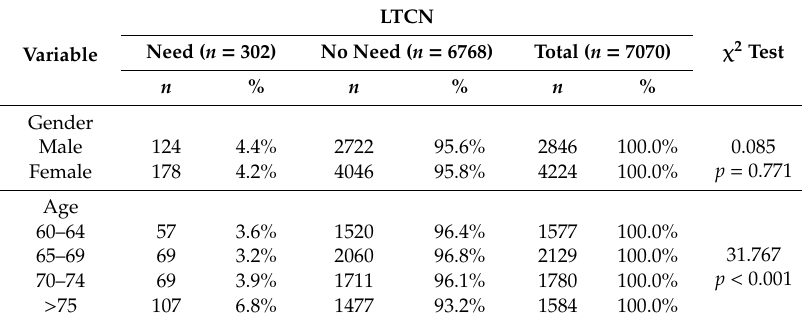
Table 2. Characteristic of Participants by